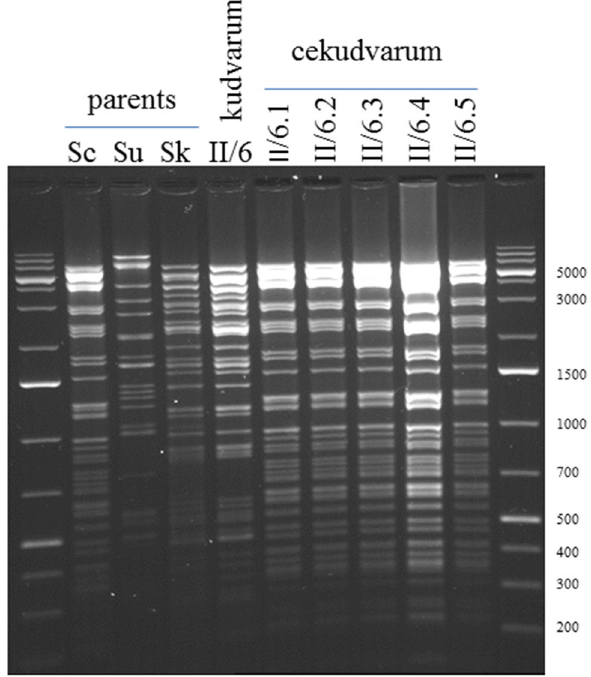
Figure 4. RFLP patterns of the mitochondrial DNA digested with Mbo I. Sc: 10–170 S. cerevisiae . Su: 10–1651 S. uvarum . Sk: 1653 S. kudriavzevii . Size ladder on the right